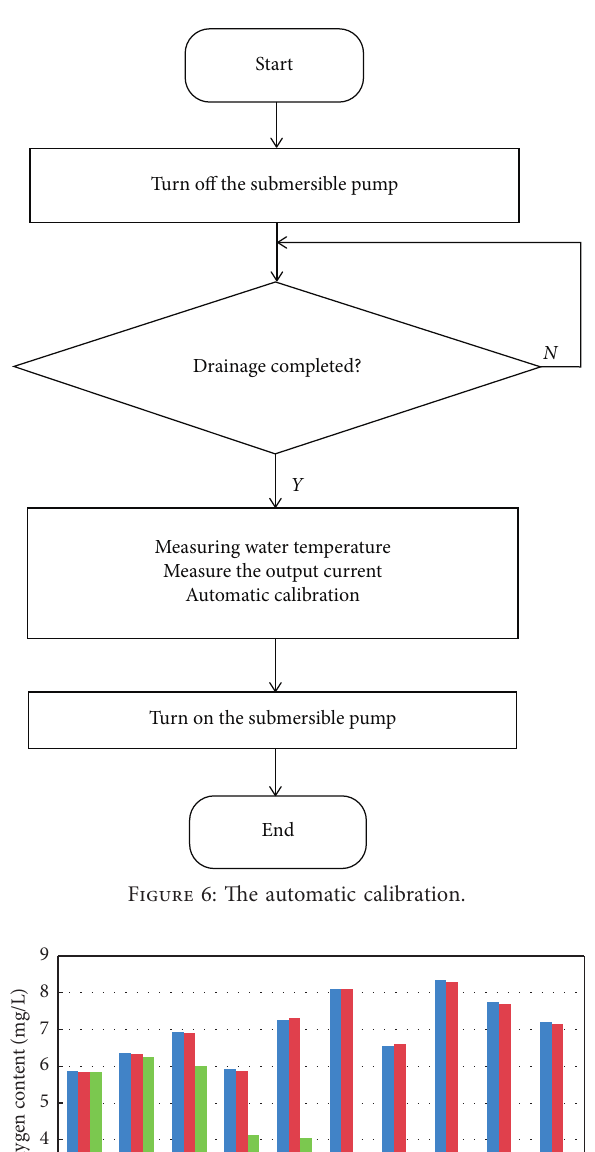
Figure 6: The automatic calibration.